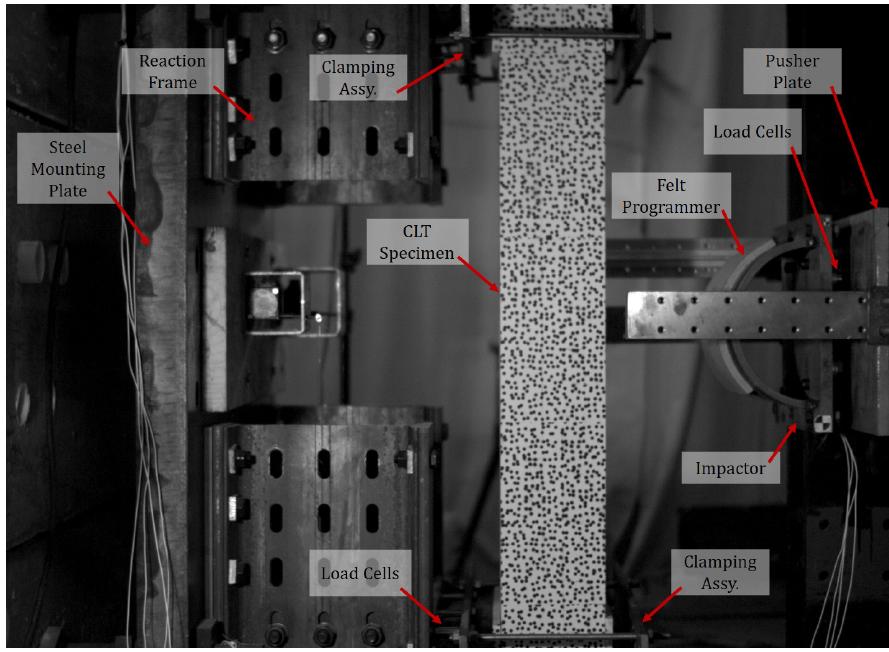
Figure 10. Impulsive center-point test